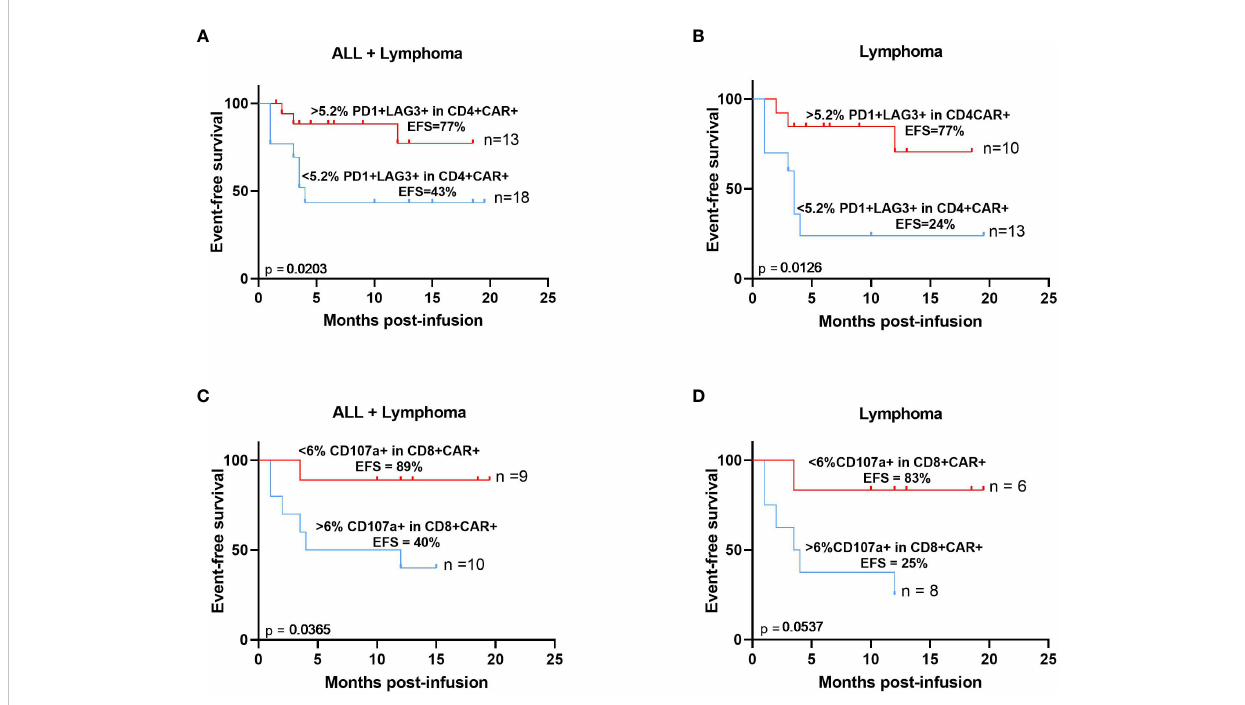
FIGURE 6 Immunophenotypic characteristics of CAR-T cells at the time of peak expansion correlate with increased event free-survival. Expression of PD1 and LAG3 >5.2% (red) within CD4 CAR-T cells at the time of peak expansion correlates with increased EFS in patients with B-ALL and lymphoma (A) or excluding patients with B-ALL (B) . Expression of CD107a <6% (red) within CD8+ CAR-T cells at the time of peak expansion correlates with increased EFS in patients with B-ALL and lymphoma (C) or excluding patients with B-ALL (D) . The median expression levels of these biomarkers were used to calculate these thresholds. Correlation studies were performed using Kaplan-Meier survival